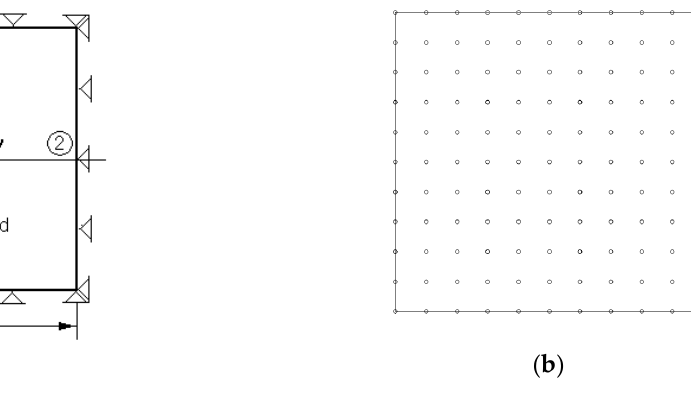
Figure 4. A simply supported, rectangular FG sandwich plate: ( a ) the geometric dimensions and loading/boundary conditions, ( b ) an 11 × 11 uniform NEM